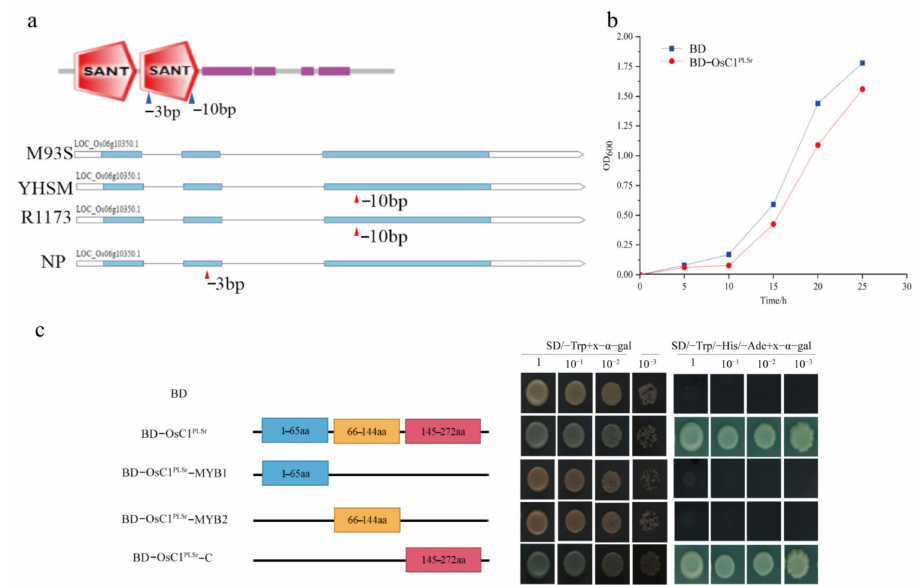
Figure 6. Structure analysis, transcriptional activation characteristics, and toxicity detection as- say. ( a ), Structure deletion site analysis of OsC1 PLSr . ( b ), Toxicity detection of OsC1 PLSr protein. ( c ), The full-length ORF of OsC1 PLSr and three truncated mutants (OsC1 PLSr -MYB1, OsC1 PLSr -MYB2, OsC1 PLSr -C) were fused with pGBKT7, and the transformed AH109 yeasts were selected from SD/- Trp + x- α -gal medium and SD/-Trp/-His/-Ade + x- α -gal medium, respectively. The empty BD vector was used as a negative control. “SANT” means “SANT SWI3, ADA2, N-CoR, and TFIIIB” DNA-binding